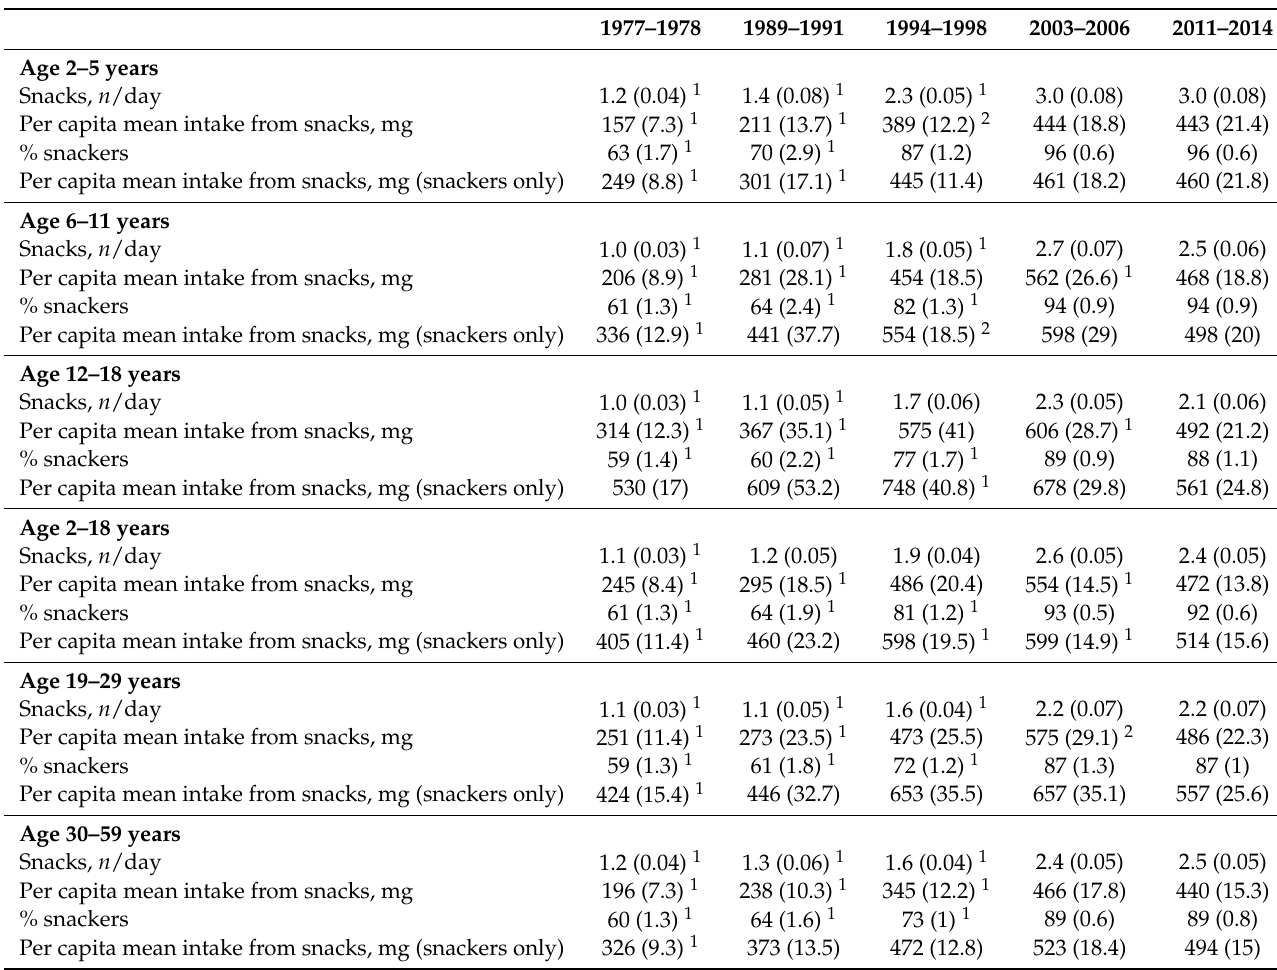
Table 1. Number of snacks consumed per day, percentage of snackers in the population, and sodium consumed per snacking occasion, by US children and adults